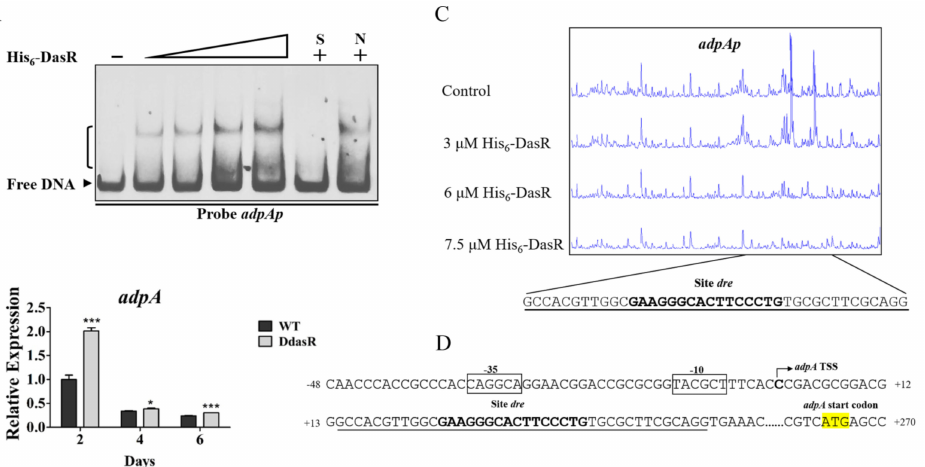
Figure 5. Identification of DasR target adpA . ( A ) EMSAs of His 6 -DasR with probe adpAp . Lanes 2–5: 1, 1.5, 3, and 4.5 µ M His 6 -DasR. Notations are as in Figure 3B. ( B ) RT-qPCR analysis of adpA in WT and DdasR grown in fermentation medium. *, p < 0.05; ***, p < 0.001 ( t -test). Error bars: SD for three replicates. ( C ) DNase I footprinting assay of DasR on adpAp . ( D ) Nucleotide sequences of adpA promoter region and DasR-binding site. Formatting conventions as in Figure 4B.